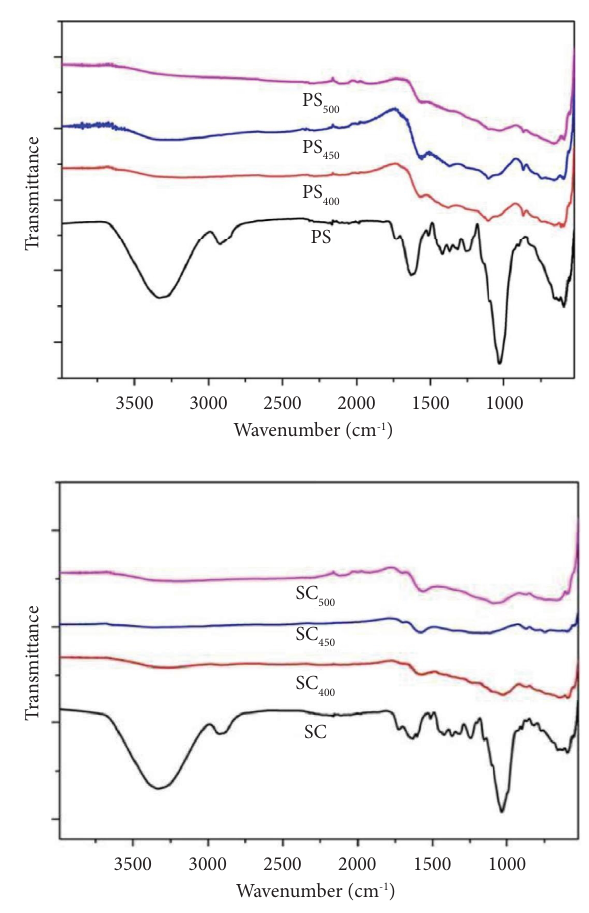
Figure 5: FTIR spectra curves of PS, PS SC 400 , SC 450 , SC 500